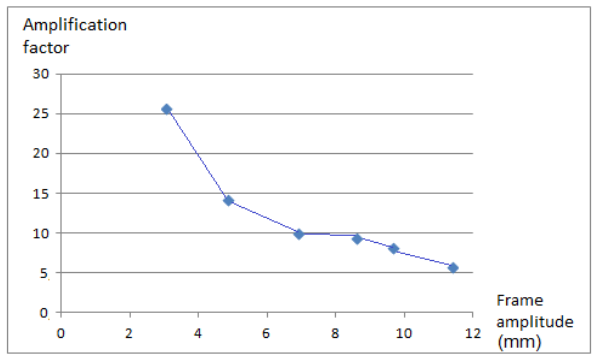
Figure 12. Variation of the amplification factor according to the table ’ s oscillation amplitude.